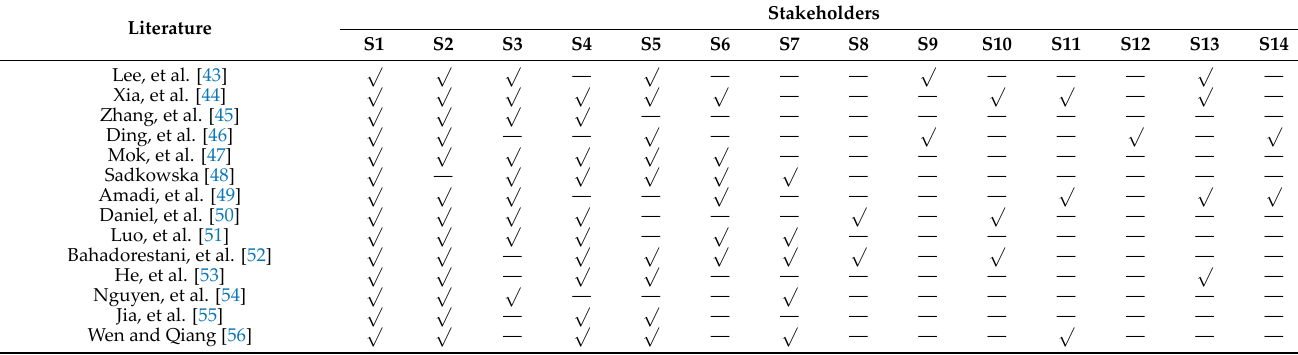
Table 2. Initially Identified